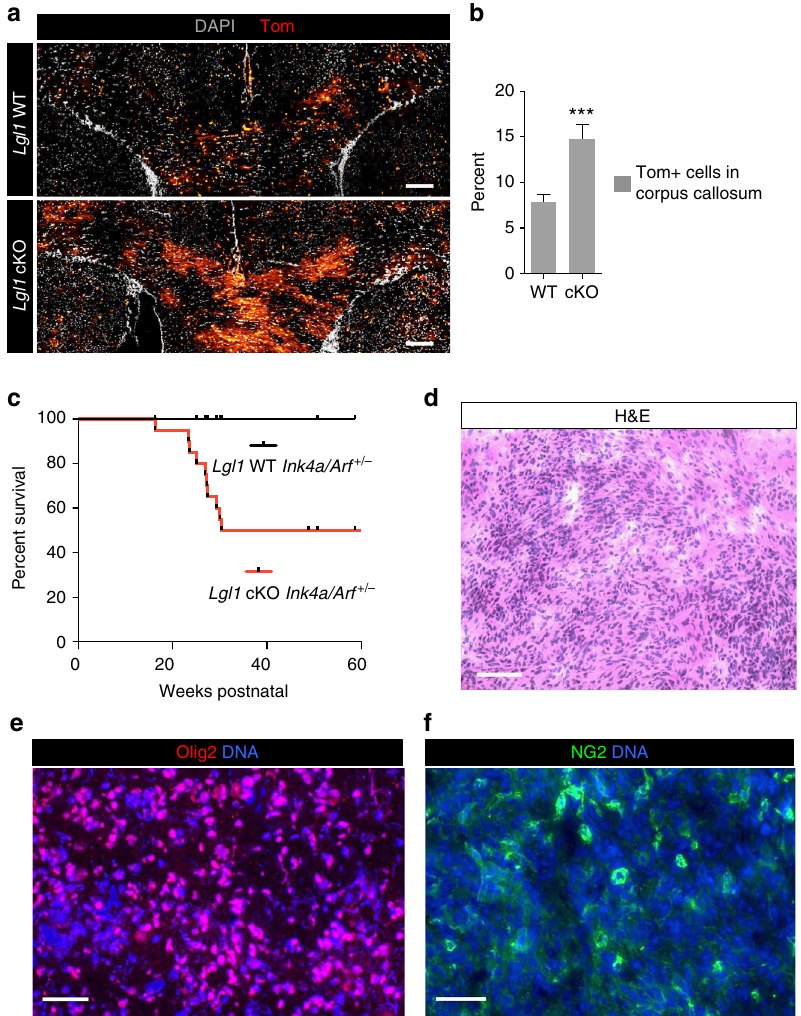
Fig. 4 Lgl1 knockout increases proliferation and promotes gliomagenesis. a Representative immunostaining of corpus callosum of Lgl1 WT mouse (top panel) and Lgl1 cKO mouse (bottom panel) for Tom (red) and co-staining for DNA (gray) after broad deletion of Lgl1 in NG2-Cre ERT2 Tom Lgl1 WT (top panel) vs. Lgl1 cKO P30 mice followed by analyses at P60 by FACS and IF. Scale bar: 200 µ m. b Quanti fi cation of Tom + cells by FACS from Lgl1 WT and Lgl1 cKO corpus callosum, showing a signi fi cant increase following Lgl1 knockout. Data are represented as mean ± s.e.m. from the analyses of 5 Lgl1 WT vs. 5 Lgl1 cKO mice (*** p < 0.001, Mann – Whitney test). c Kaplan – Meier survival curve for Lgl1 WT ( Lgl1 wt/wt ; NG2Cre; Ink4a/Arf + /- ) and NG2Cre-driven homozygous Lgl1 cKO ( Lgl1 fl / fl ; NG2Cre; Ink4a/Arf + /- ) mice. Six animals were analyzed for each genotype. d Hematoxylin and Eosin (H&E) staining of endogenous tumors in Lgl1 cKO mice, showing in fi ltrative growth. Scale bar: 100 μ m. e , f Immunostaining of endogenous tumors in Lgl1 NG2-Cre mice for Olig2 (blue, e ) and NG2 (green, f ). Scale bar: 50 μ